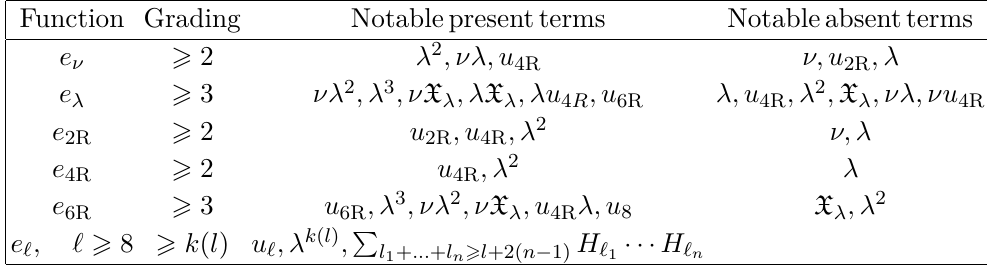
. We only show the variables on which the terms i